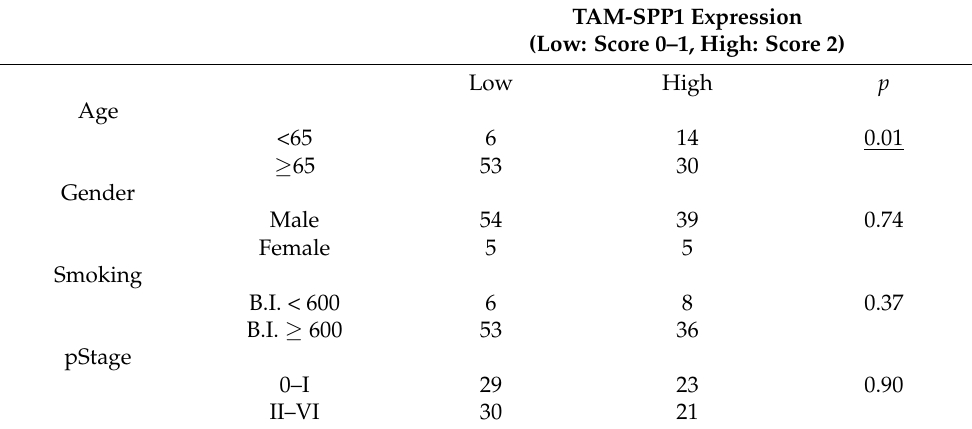
Table 3. TAM-SPP1 expression and clinicopathological factors;